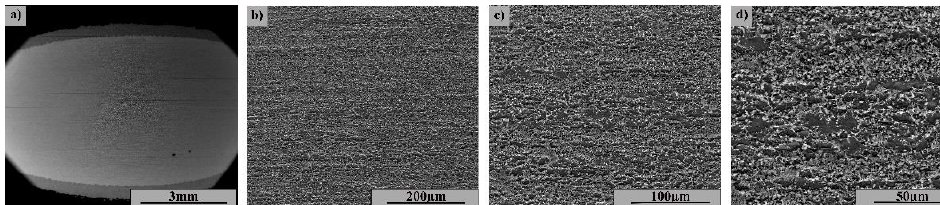
500×; ( c ) 1000×; ( d ) 2000×.